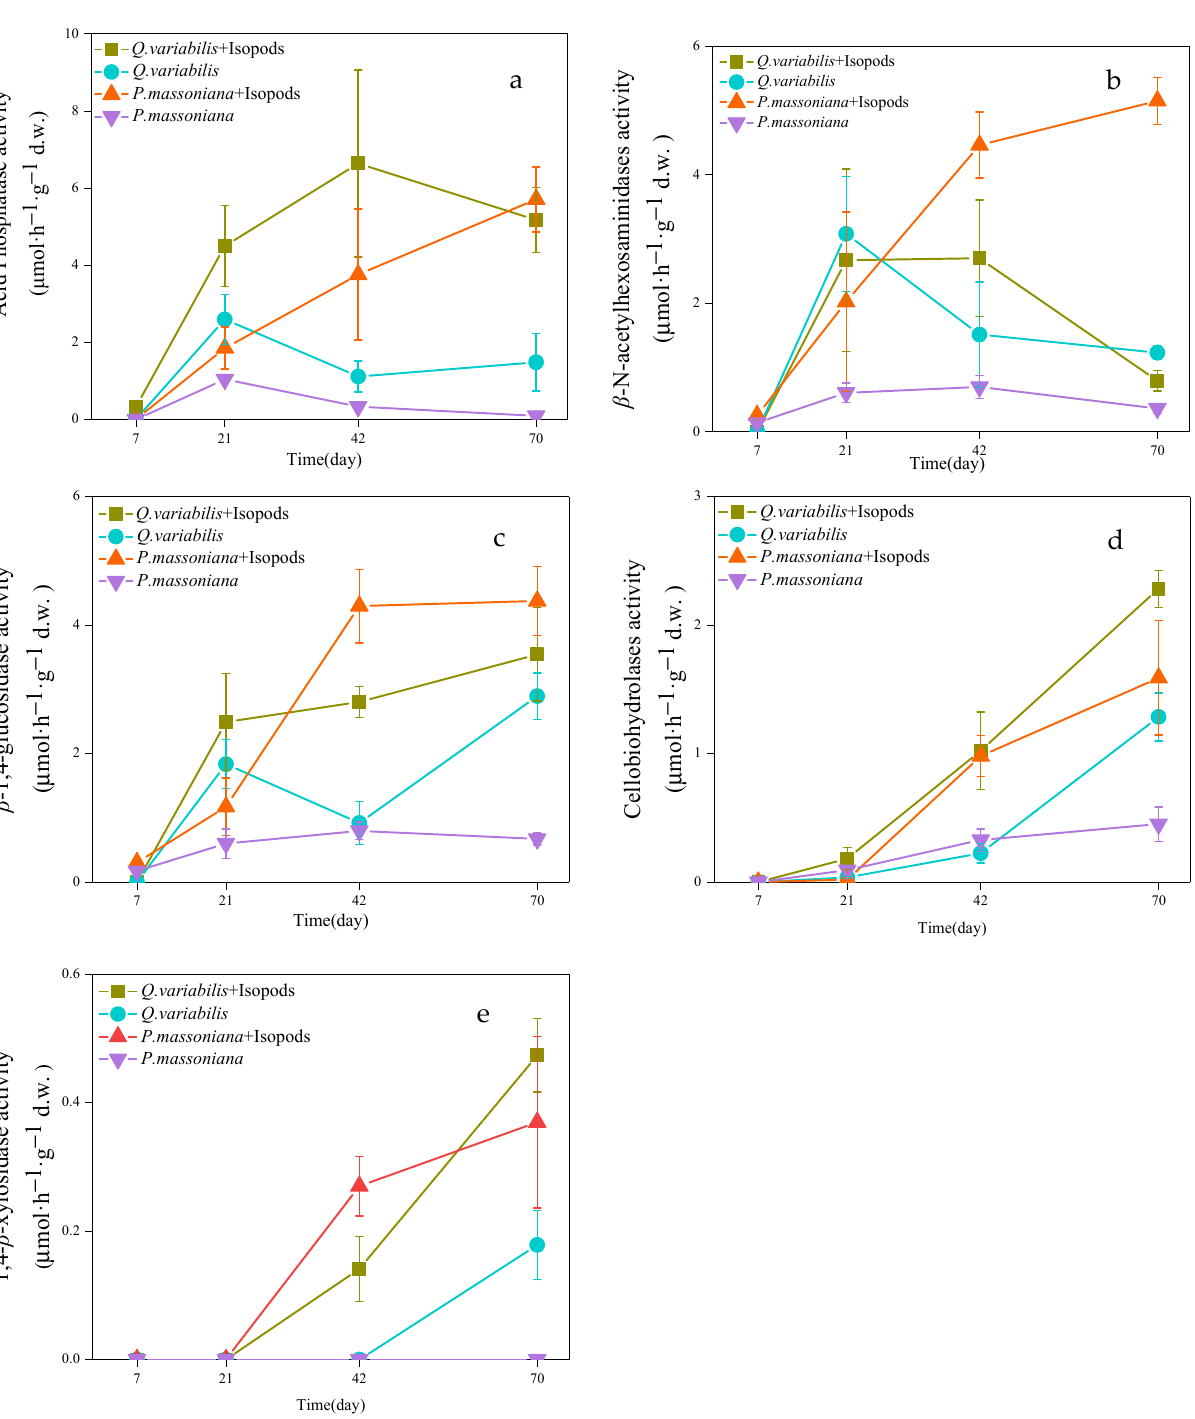
Figure 3. Changes in the activities of acid phosphatase ( a ), β - N -acetylhexosaminidases ( b ), β -1,4- glucosidase ( c ), cellobiohydrolases ( d ), 1,4- β -xylosidase ( e ) of litter in the decomposition area under different treatments during 70 days incubation. The zymogram images of acid phosphatase, β -N-acetylhexosaminidase and β -1,4- glucosidase in the grazing area at 7 days, 21 days, 42 days and 70 days are shown in Figures 4 and 5. The color of zymogram images could be divided into red, orange, yellow, green, blue and dark blue, which represents the enzyme activity from high to low and even no activity